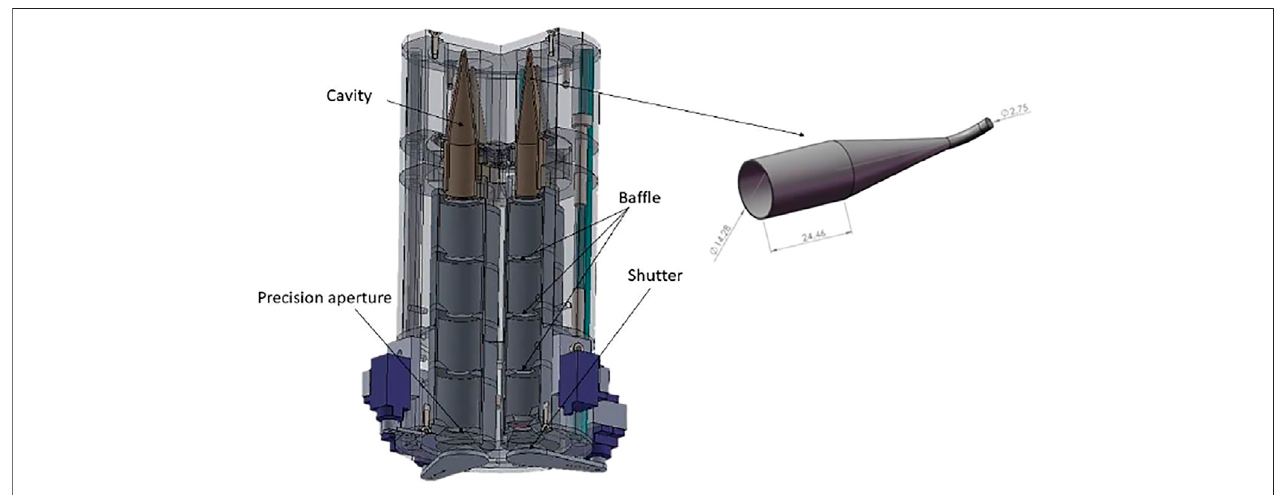
FIGURE 7 | Classical cavity radiometer schematic